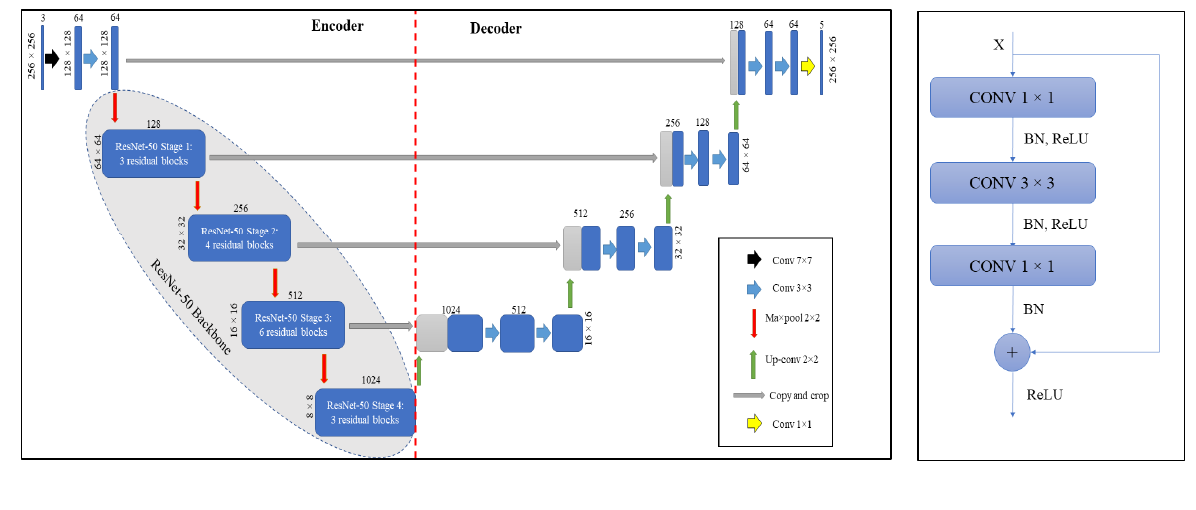
Figure 4. ( a ) Architecture of U-Net with ResNet-50 backbone. ( b ) Diagram of bottleneck residual block in ResNet-50.